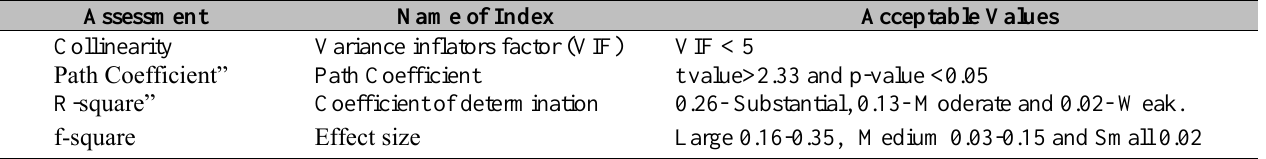
Tolerable “Values for Model Evaluation- Structural Model